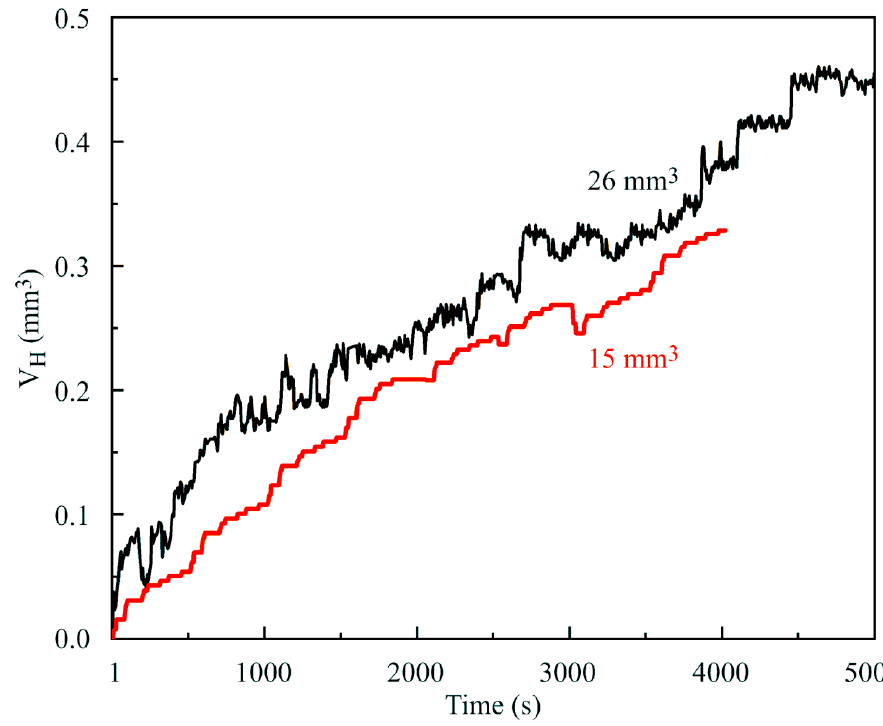
Figure 4. Dependence of hexane volume retained within the water drop on time for initial drop volumes of 15 mm 3 (red curve) and 26 mm 3 (black curve) and capillary diameters of 2 mm and 3 mm, respectively.